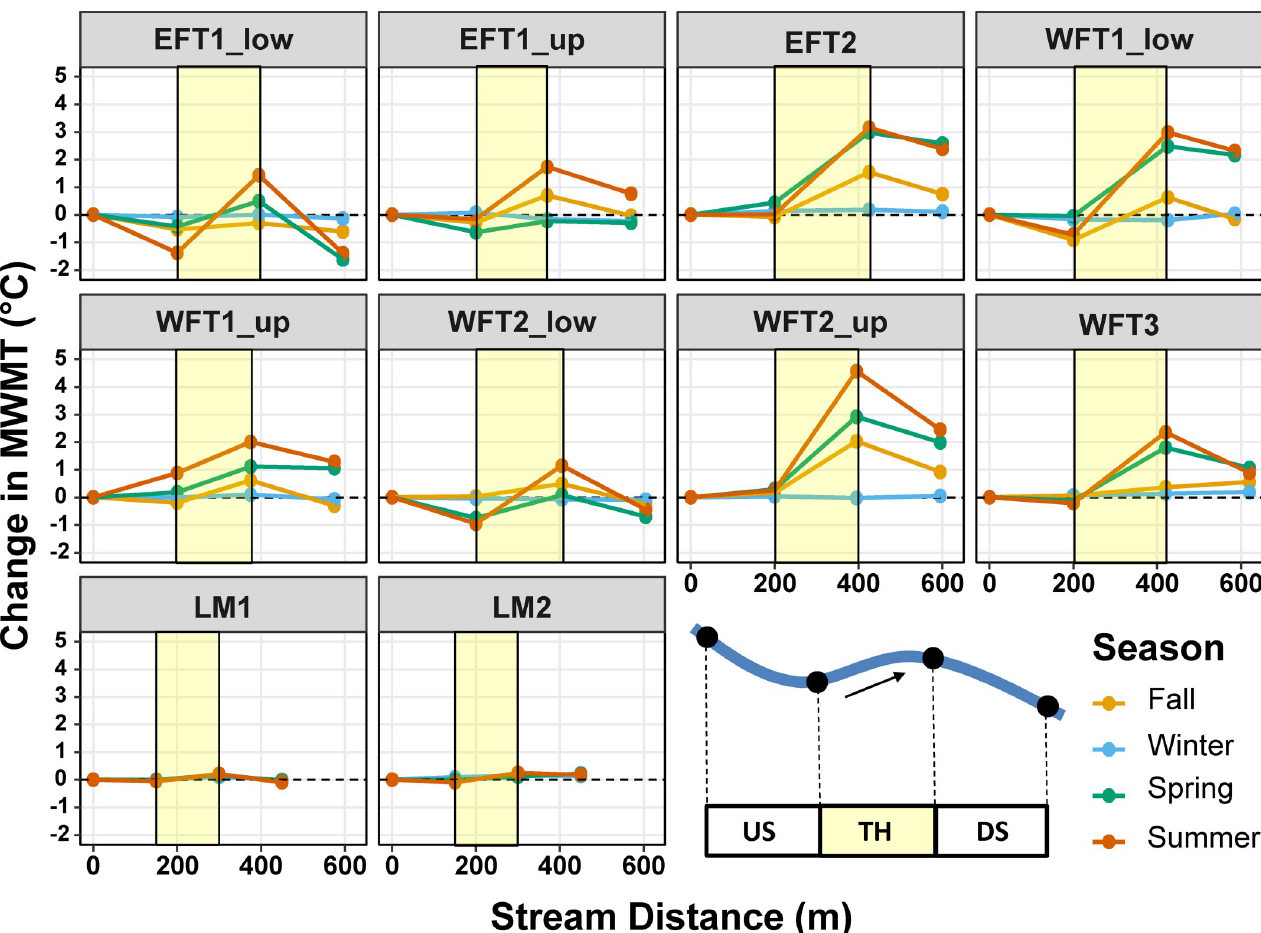
Fig 4. Reach-scale longitudinal profiles of stream temperature responses. Seasonal variation in reach-scale longitudinal profiles of stream temperature responses (pre-treatment—post-treatment) in upstream reference (US), thinned (TH), and downstream (DS) reaches for individual sites (n = 10) in northern California second-growth redwood forests. The position of thinned reaches is indicated by the yellow polygons. Black dots on blue line depict temperature sensor locations along upstream, thinned, and downstream reaches.